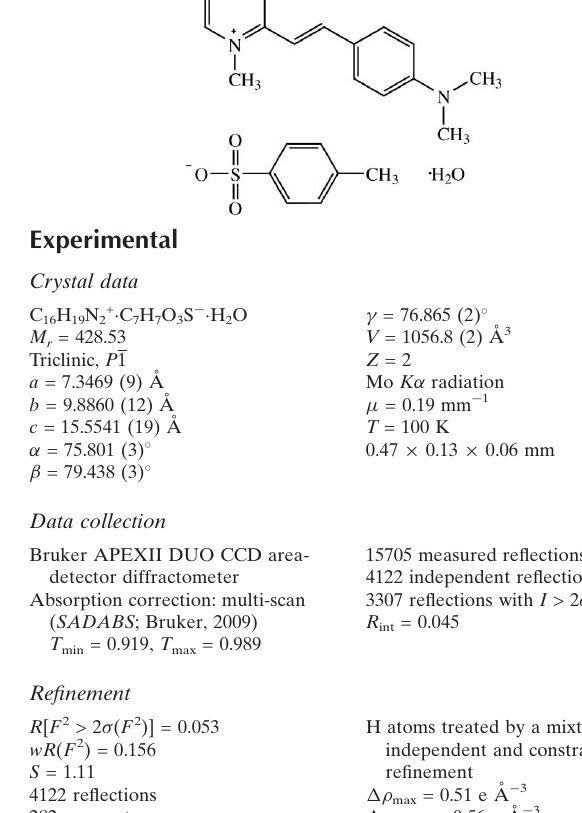
Absorption correction: multi-scan ( SADABS ; Bruker, 2009)